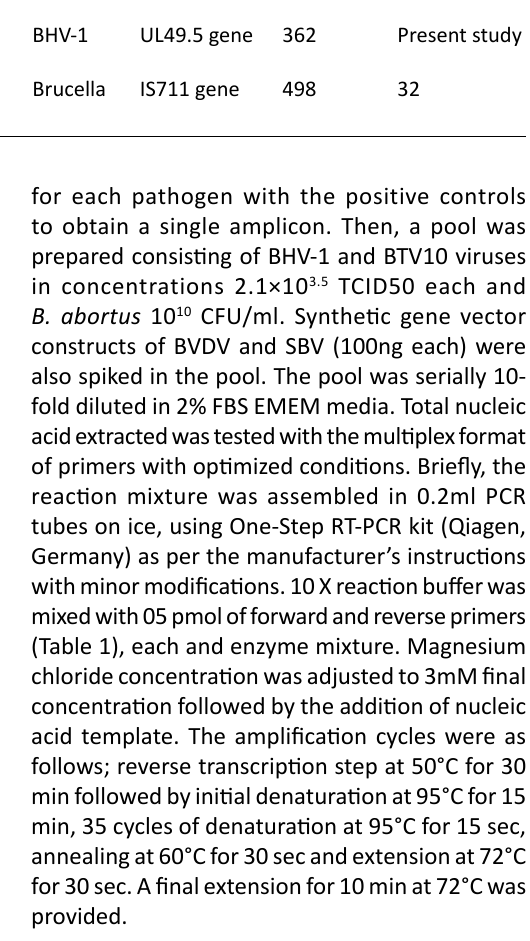
Table 2. Details of samples used for validation in this study S.No.